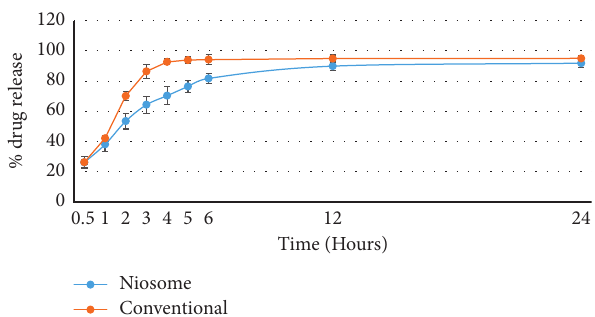
Figure 2: In vitro release of niosome and conventional levofloxacin formulations ( p < 0 . 33).